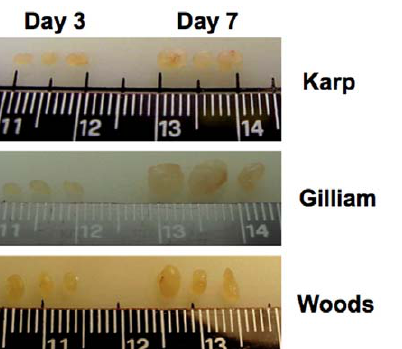
Figure 1. Macroscopic evidence of regional lymphadenopathy in O.tsutsugamushi inoculated mice. Gross examination of draining lymph nodes (right superficial parotid lymph node) from O. tsutsuga- mushi inoculated mice at day 3 pi (left) and day 7 pi (right) shows enlargement of lymph nodes at day 7. Top panel: Karp-inoculated mice, Middle panel: Gilliam-inoculated mice, Bottom panel: Woods-inoculated mice. goat anti-mouse IgG 1 antibody (Molecular Probes, Eugene, OR,